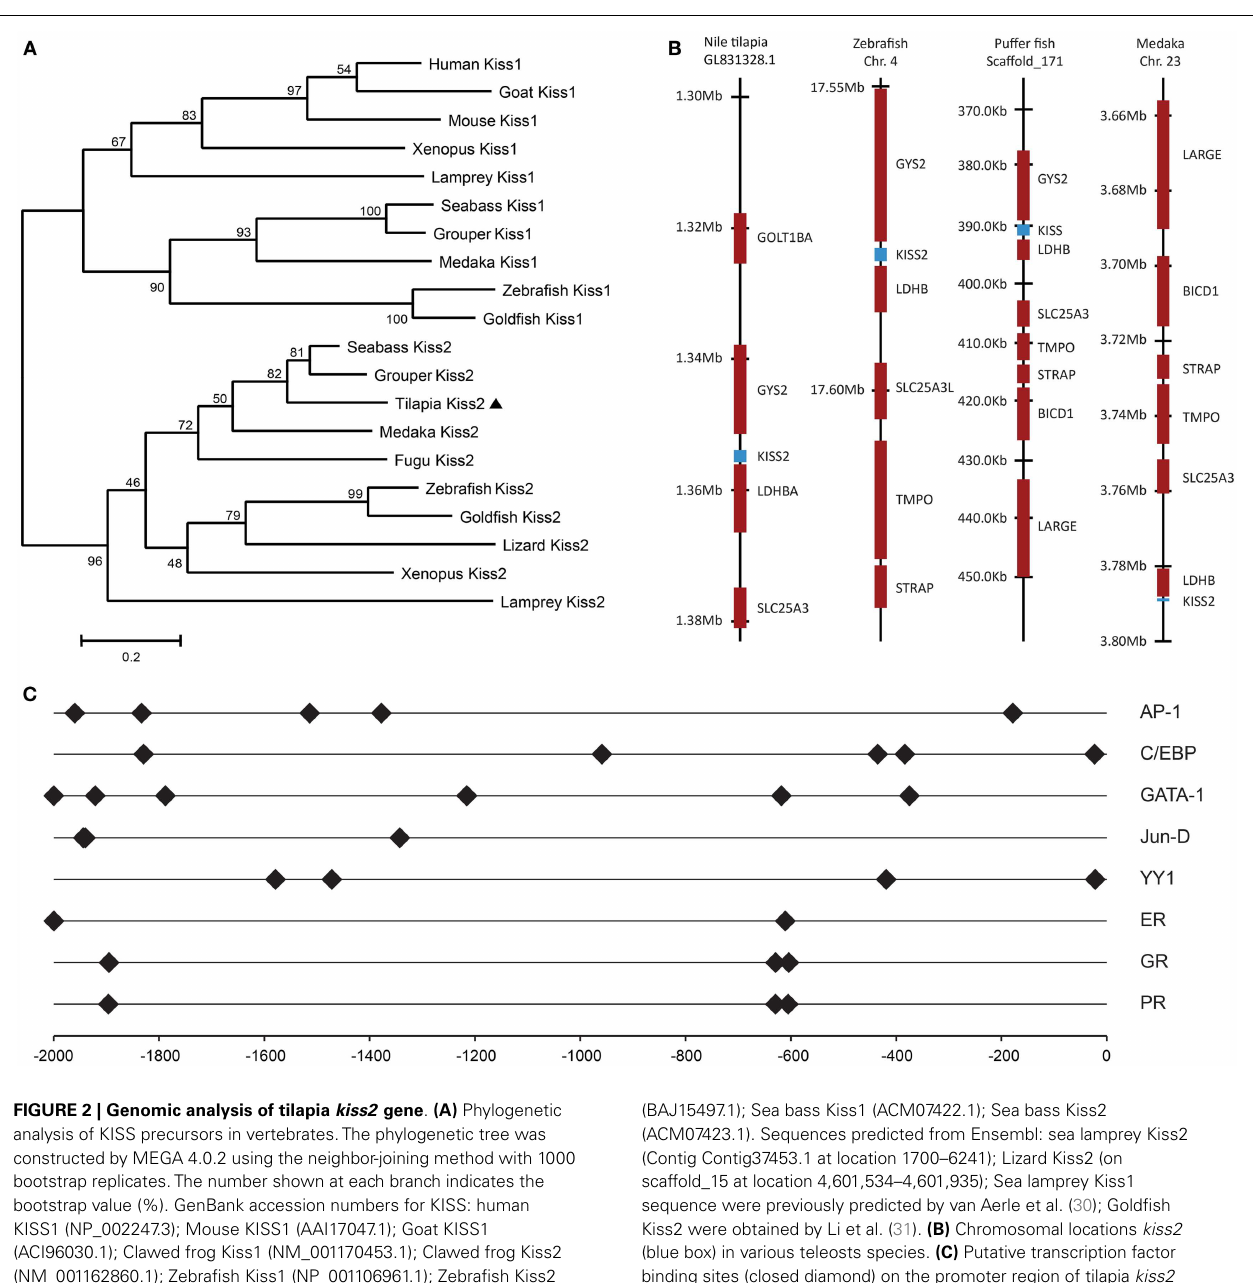
(BAJ15497.1); Sea bass Kiss1 (ACM07422.1); Sea bass Kiss2 (ACM07423.1). Sequences predicted from Ensembl: sea lamprey Kiss2 (Contig Contig37453.1 at location 1700–6241); Lizard Kiss2 (on scaffold_15 at location 4,601,534–4,601,935); Sea lamprey Kiss1 sequence were previously predicted by van Aerle et al. (30); Goldfish Kiss2 were obtained by Li et al. (31). (B) Chromosomal locations kiss2 (blue box) in various teleosts species. (C) Putative transcription factor binding sites (closed diamond) on the promoter region of tilapia kiss2 gene.The numbers − 2000 to 0 represent distance in bp from the putative transcriptional initiation